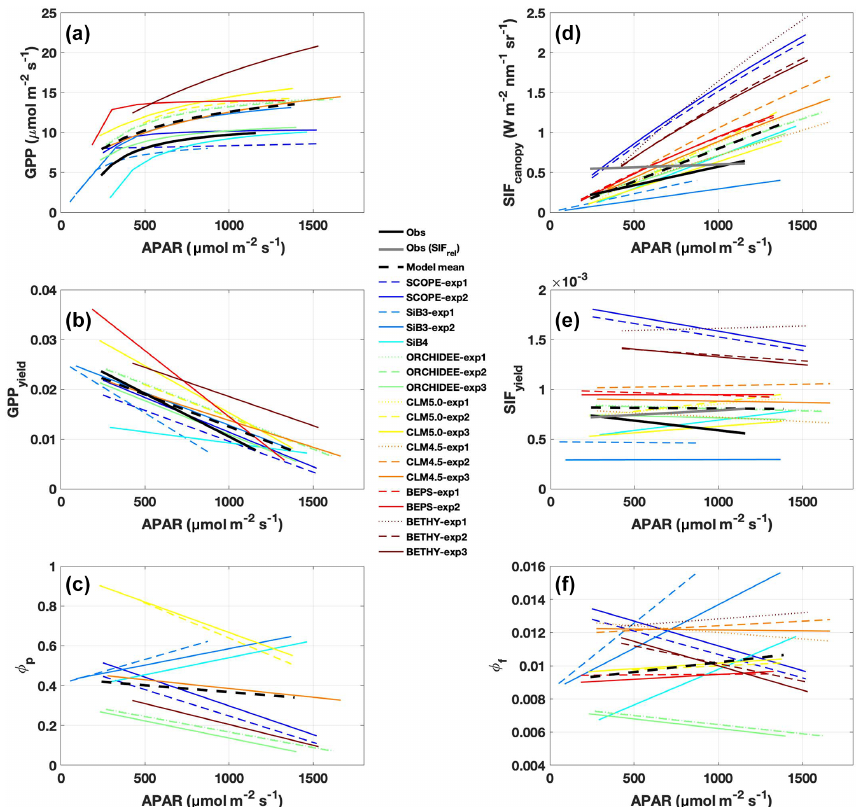
Figure 5. Observed and predicted change in GPP, SIF, and yields with APAR. Regression lines are shown for (a) GPP, (b) GPP yield , (c) photochemical quantum yield ( φ P ), (d) SIF canopy , (e) SIF yield , and (f) fluorescence quantum yield ( φ F ), as a function of APAR, using daily mean (08:00–16:00LT) values over the period July–August 2017. Observations are shown in solid black; individual models and experiments are in color; the across-model average is a dashed black line. Relative SIF is shown in grey in panels (d) and (e)